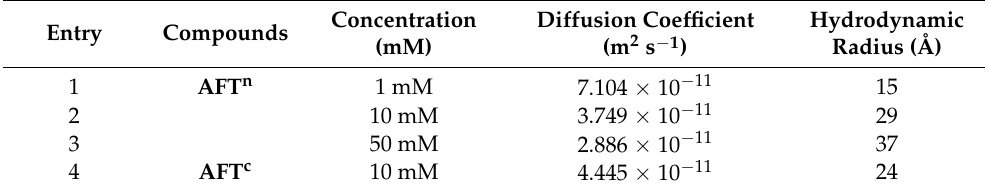
Table 1. Characterization of polycondensation reactions by DOSY-NMR. The hydrodynamic radius was determined using the Stokes–Einstein